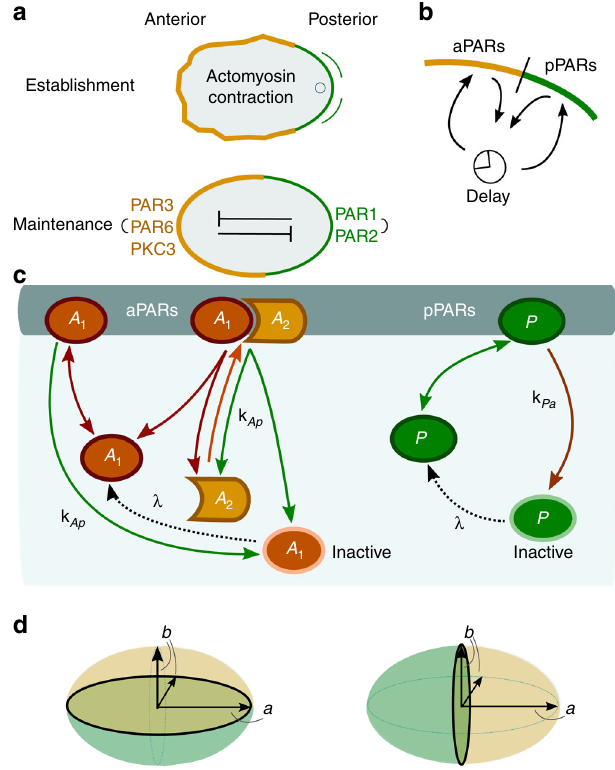
Fig. 1 Biological background and model network. a Cell polarisation in the C. elegans embryo during the establishment (top) and maintenance (bottom) phases; sketch adapted from ref. 5 . b Illustration of protein fl ux between the cytosol and membrane. As proteins detach from the membrane when phosphorylated, they cannot immediately rebind to the membrane. There is therefore an intrinsic delay before dephosphorylation permits rebinding. c The biochemical reaction network is comprised of two mutually antagonistic sets of proteins, aPARs and